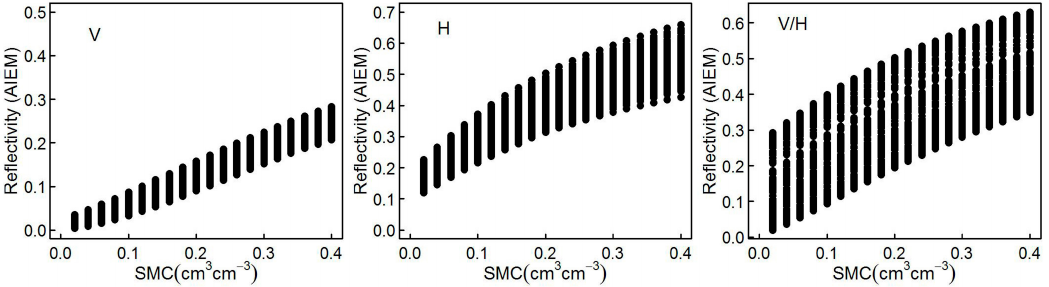
Figure 1. Frequency and polarization characteristics of surface roughness effects on the effective surface reflectivity from the advanced integral equation model (AIEM) simulated data at an incident angle of 55 ° . The first row gives the AIEM simulated effective surface reflectivity versus the corresponding Fresnel reflectivity for vertical ( V ) polarization, whereas the second row does the same, but for horizontal ( H ) polarization ( Rv : reflectivity for vertical polarization; Rh : reflectivity for horizontal polarization).